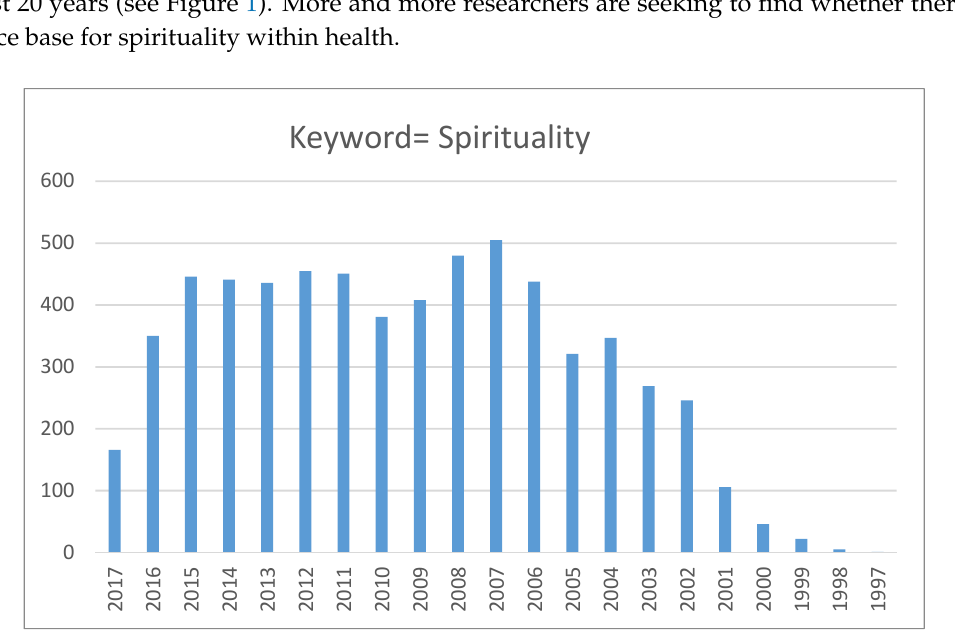
Figure 1. Articles on spirituality in PubMed 1997–2017.